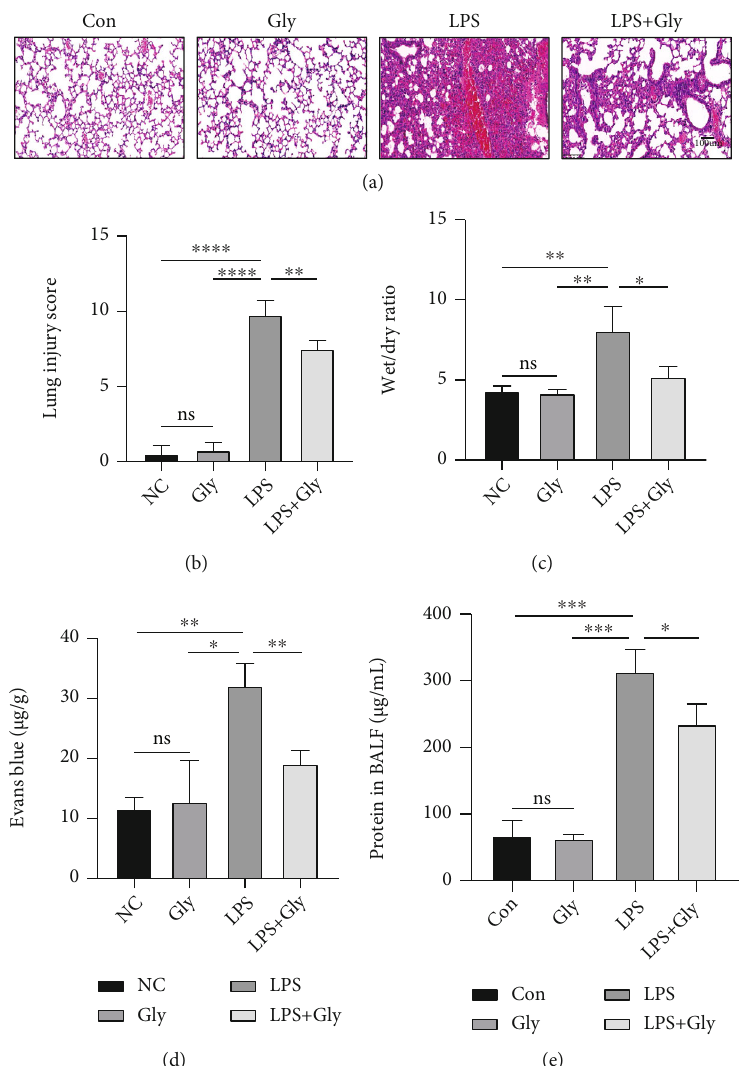
Figure 1: The e ff ect of glibenclamide on the pathological injury in LPS-induced ALI. (a) The pathological alternations in lung tissues were evaluated with HE staining ( n = 4 ). (b) Lung injury scores in four groups. (c) Wet/dry ratio in four groups ( n = 4 ). (d) Alveolar-capillary leakage in four groups ( n = 3 ). (e) The total protein concentration in BALF ( n = 3 ). Scale bars, 100 μ m. Data are representative of three independent experiments (mean and SD). ns: not signi fi cant. ∗ P < 0 : 05 , ∗∗ P < 0 : 01 , and ∗∗∗ P < 0 : 001 (unpaired Student ’ s t